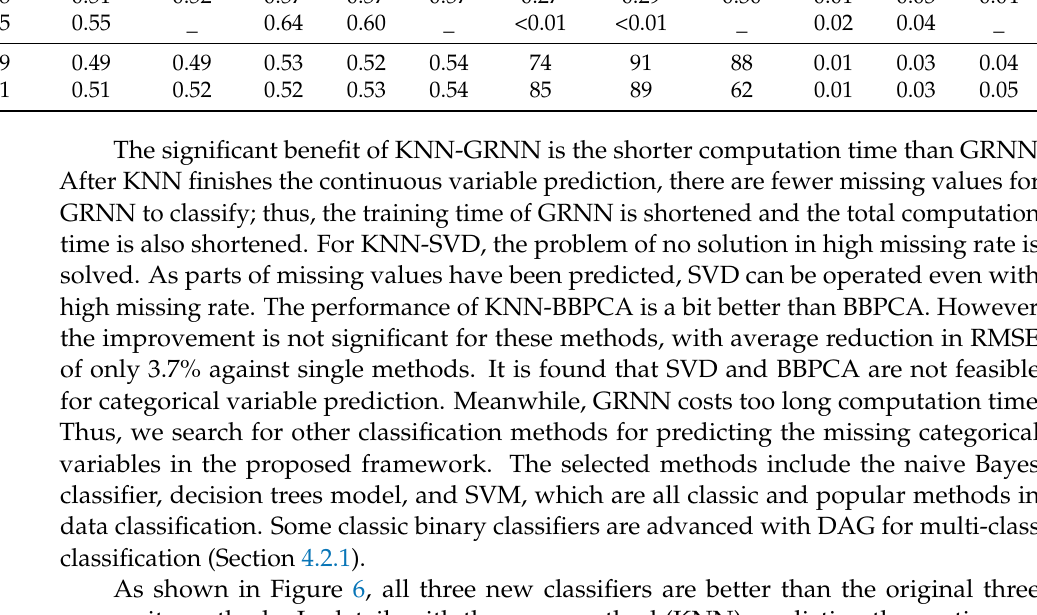
Table 2. Comparison of single and composite methods.